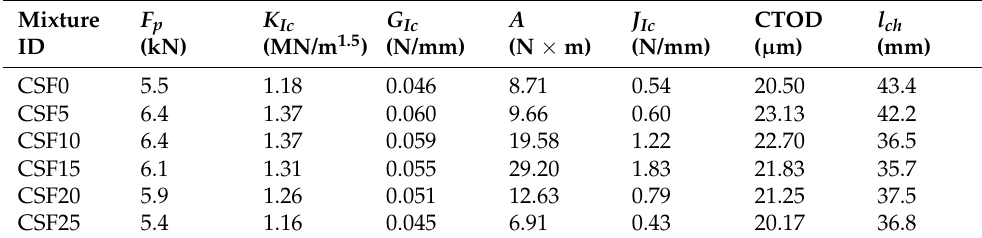
Table 5. Average fracture characteristics of HPC with various CSF content.